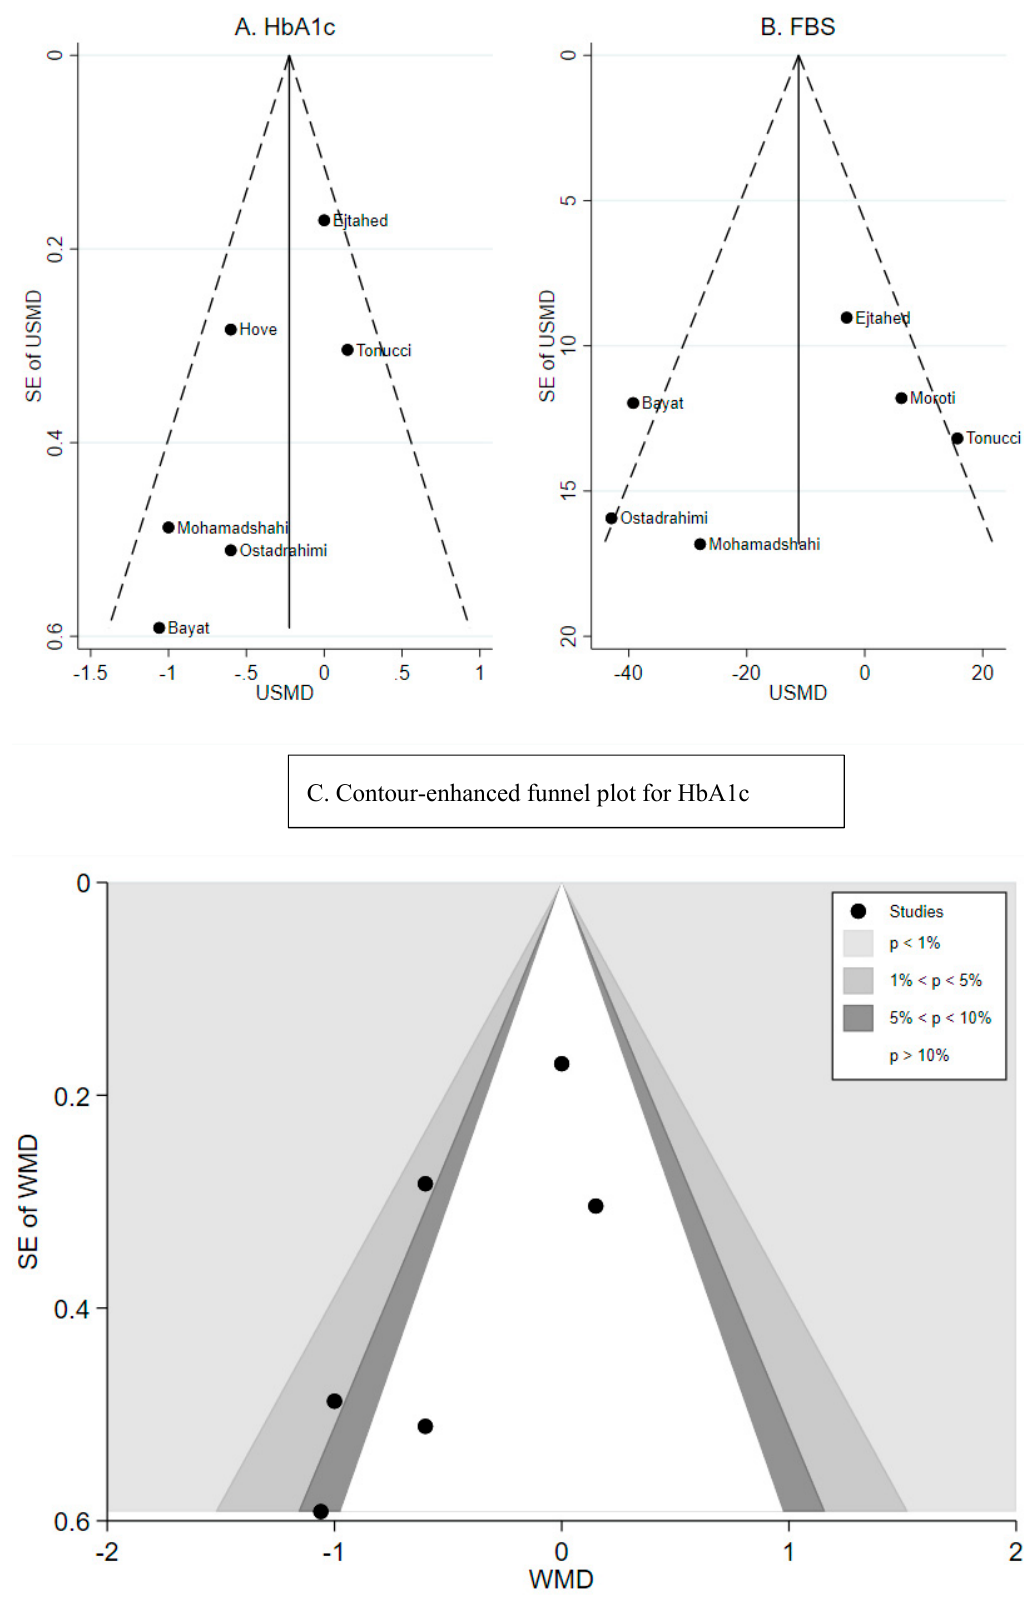
Figure 3. Risk of publication bias. The funnel plots ( A ) HbA1c, ( B ) fasting blood glucose, and ( C ) the contour-enhanced funnel plot for HbA1c.